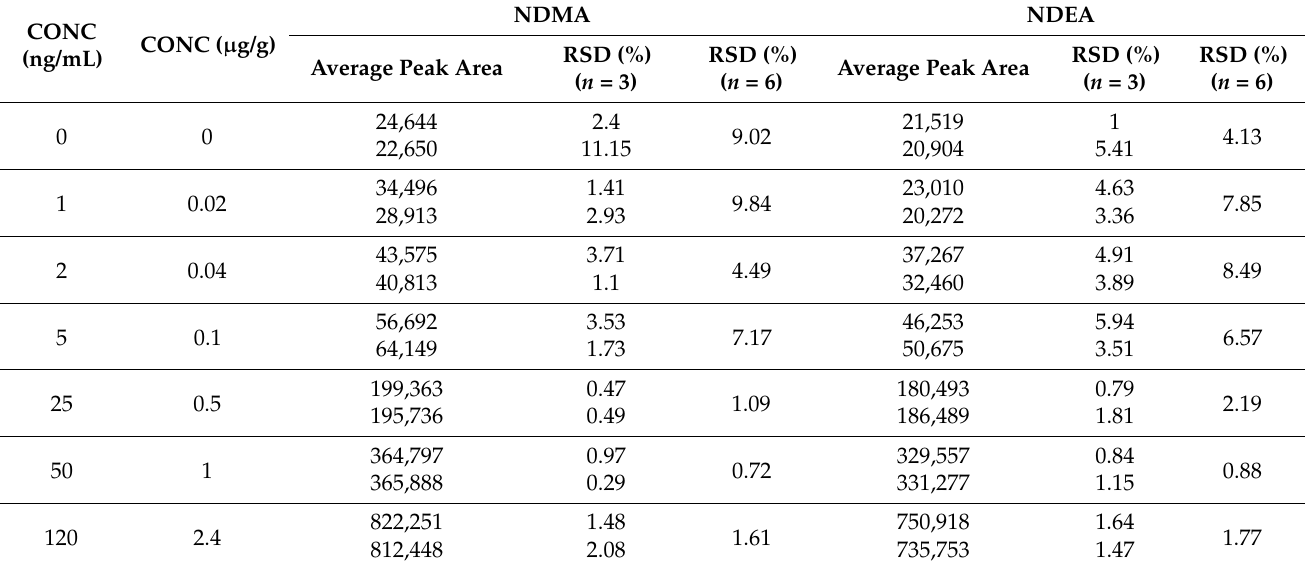
Table 2. Peak areas and relative standard deviations obtained in the linearity–precision